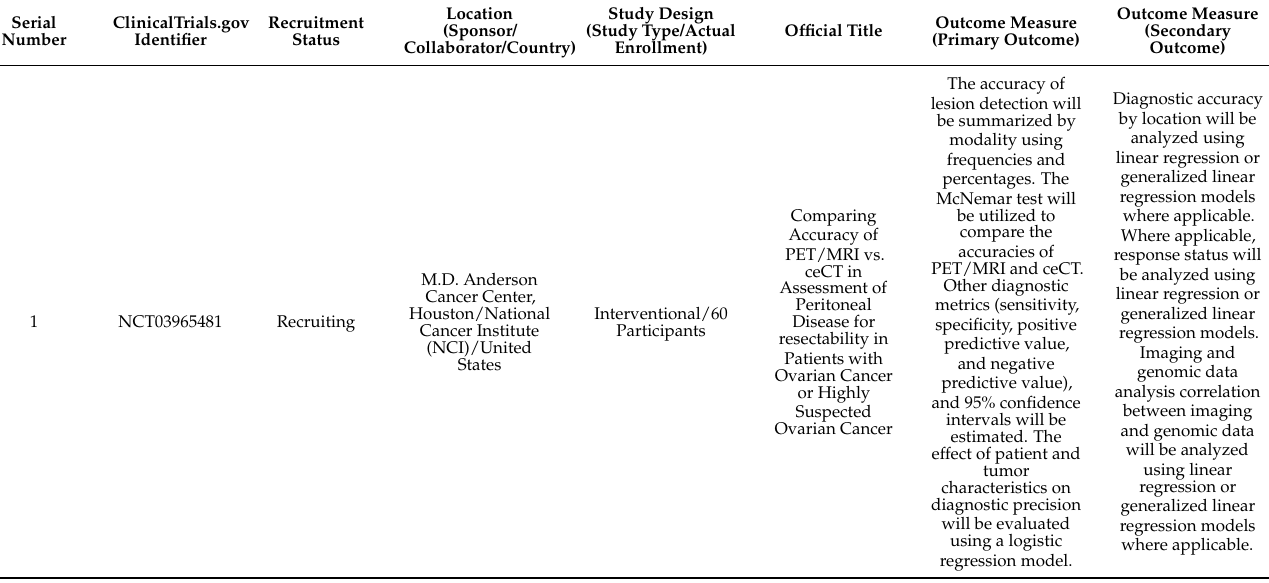
Table 8. PET/MRI Clinical Trials